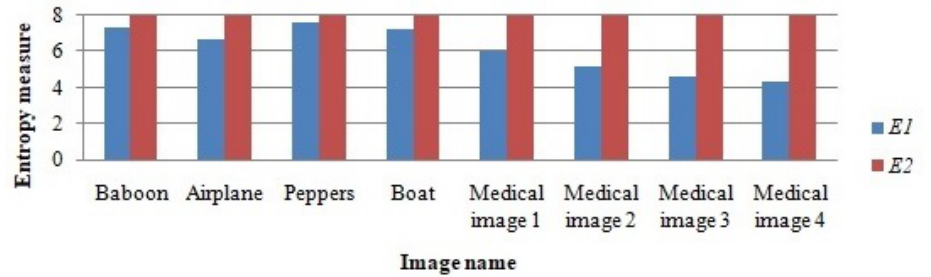
Figure 10. Entropy measure observed from original image ( E 1) and from the final encrypted image with hidden data ( E